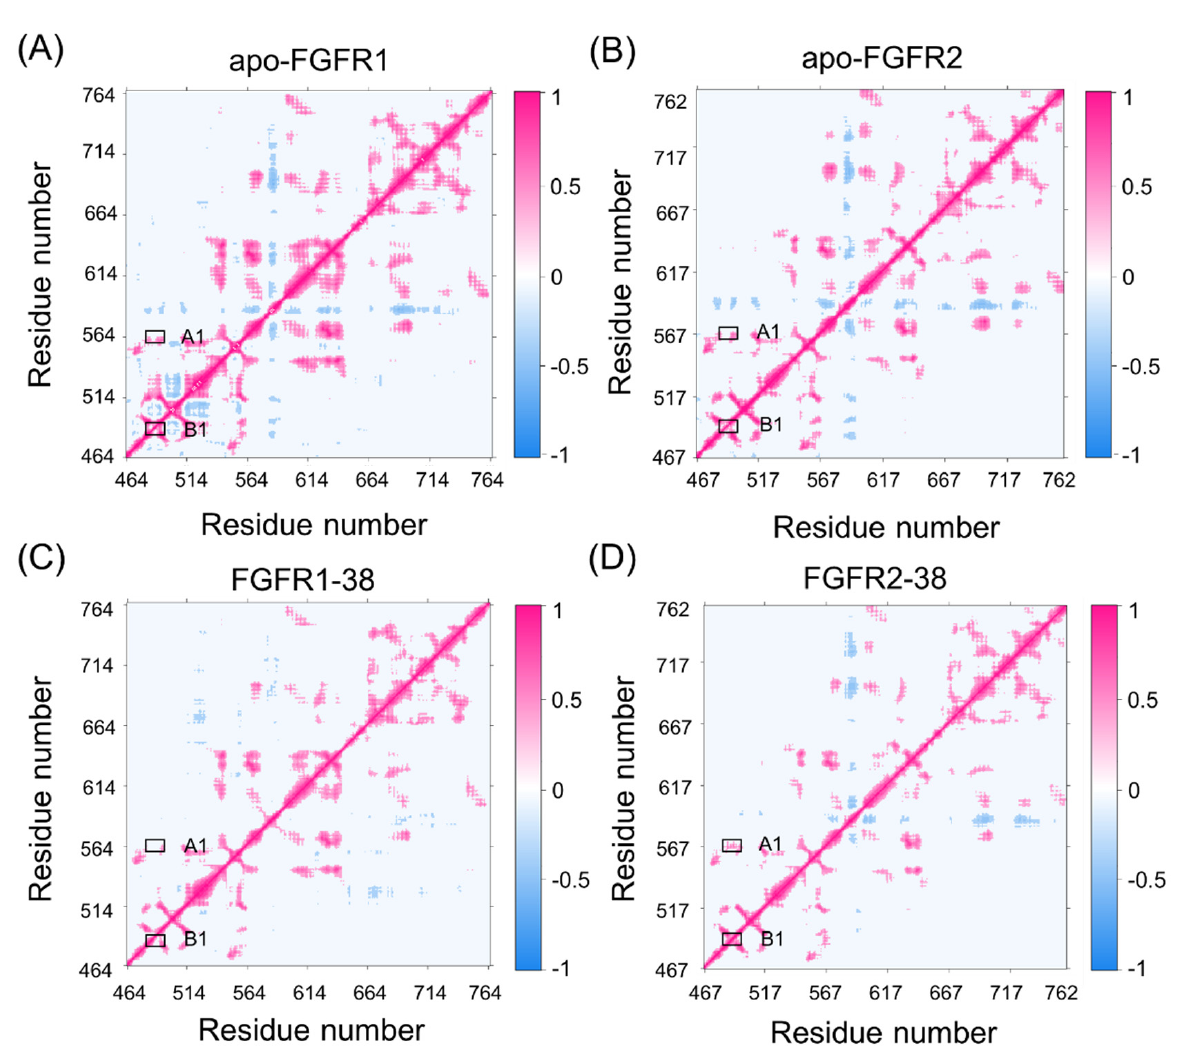
residues. According to the color-coded modes, the pink indicates correlated motions between residues, while the blue indicates anti-correlated motions between residues.